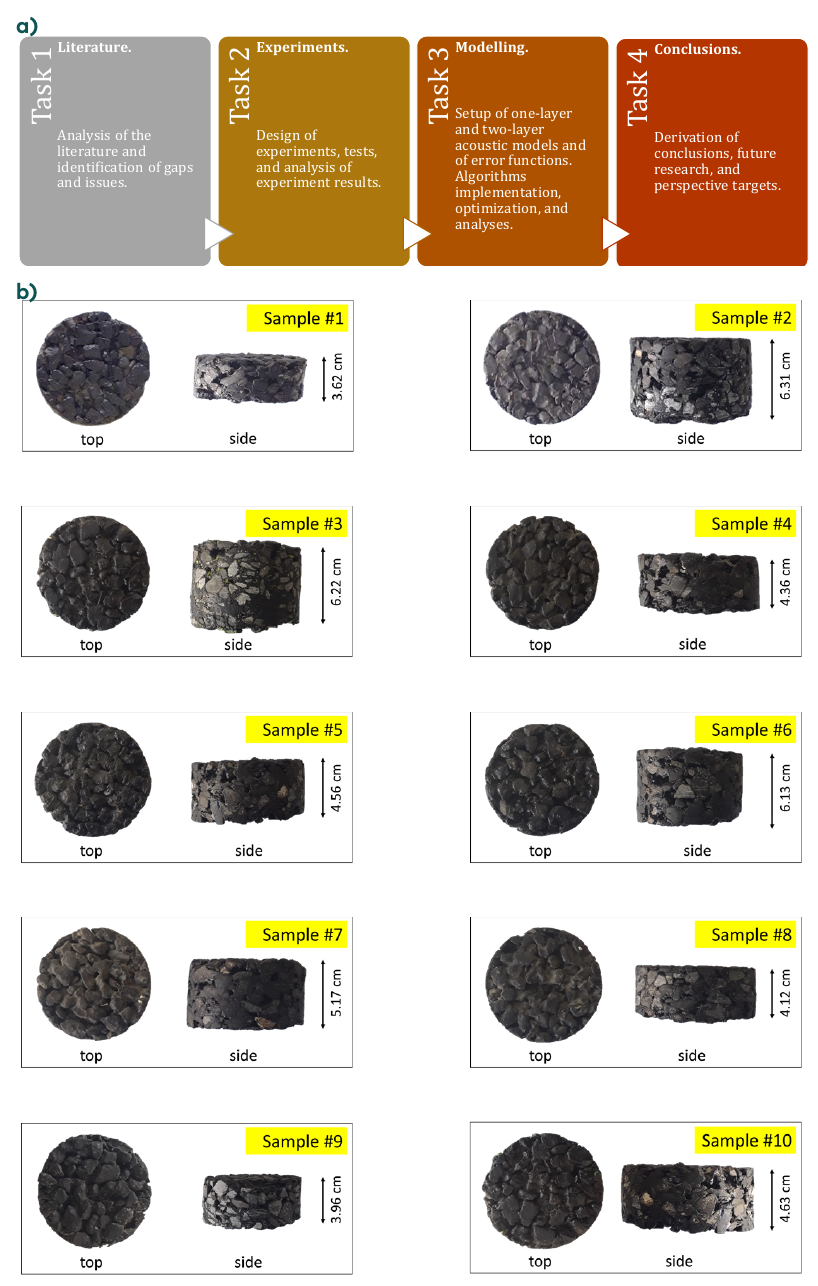
Figure 2. a) Tasks of the experimental research plan; b) upper (top)